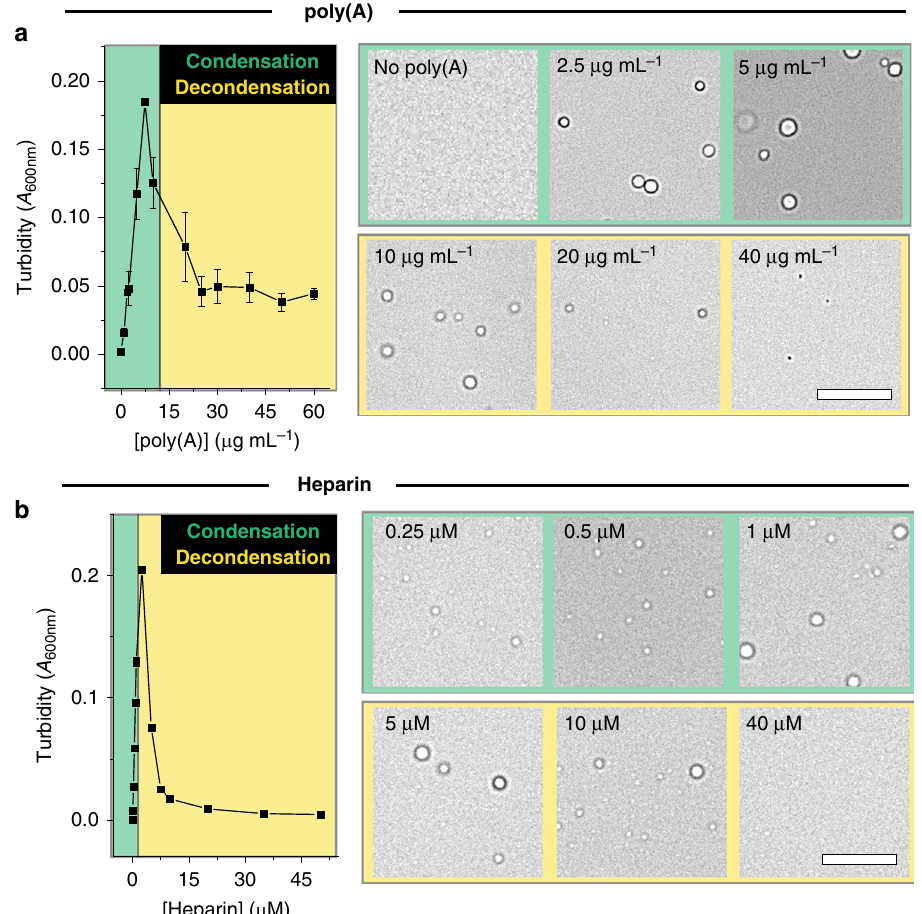
Fig. 2 Poly(A) and heparin induce LLPS and a reentrant phase transition with TDP-43 LCD. a Turbidity of TDP-43 LCD as a function of poly(A) concentration (left) and representative bright fi eld microscopy images of droplets in the presence of different concentrations of poly(A) (right), indicating that low concentrations of poly(A) promote condensation while high concentrations result in decondensation. b Turbidity of TDP-43 LCD as a function of heparin concentration (left) and representative bright fi eld microscopy images of droplets in the presence of different concentrations of heparin (right). Experiments were performed using 5 μ M TDP-43 LCD in a 20 mM potassium phosphate buffer, pH 6.0. Scale bars: 10 μ m. ( n ≥ 3 technical replicates). All data are presented as mean values± standard